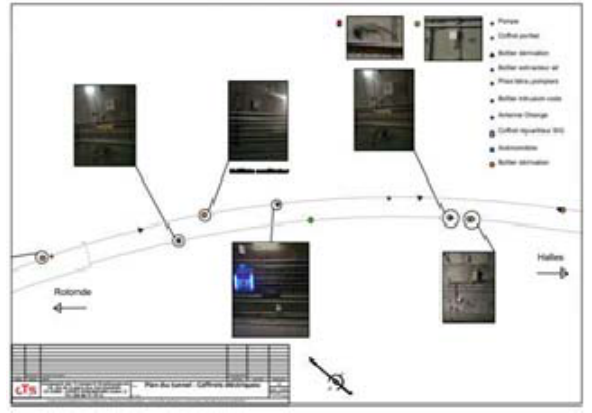
Fig. 6: 2D plan with implantation of technical